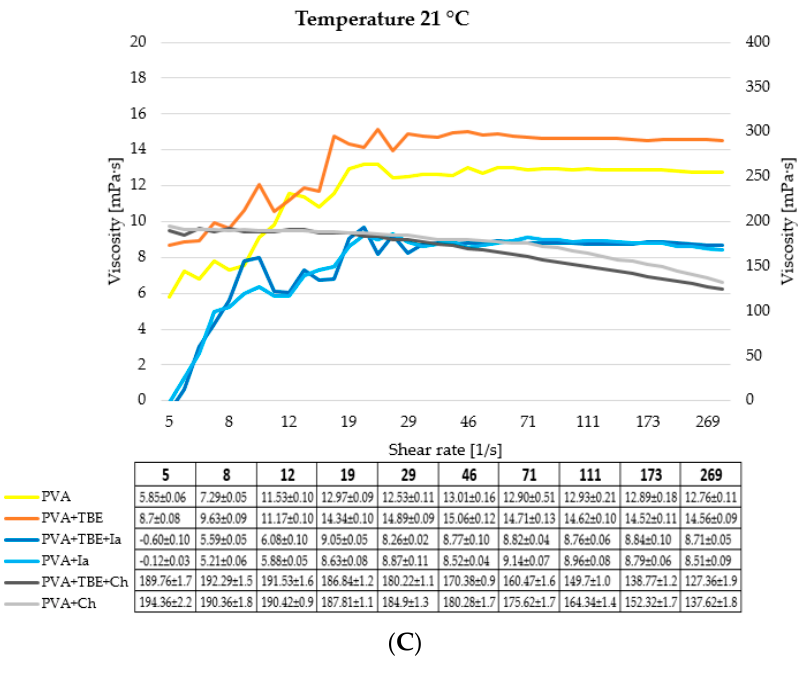
Figure 3. Relationship between viscosity and shear rate at 37 °C ( A ), 30 °C ( B ), 21 °C ( C ) for PVA, PVA + TBE, PVA + TBE + itaconic acid (Ia), and PVA + TBE + Ch.